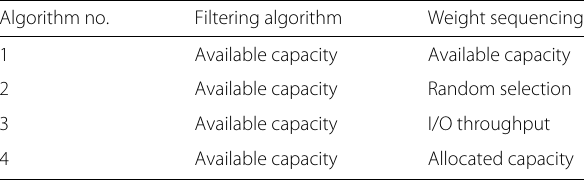
Table 1 Combination of filtering algorithm and weighting algorithm